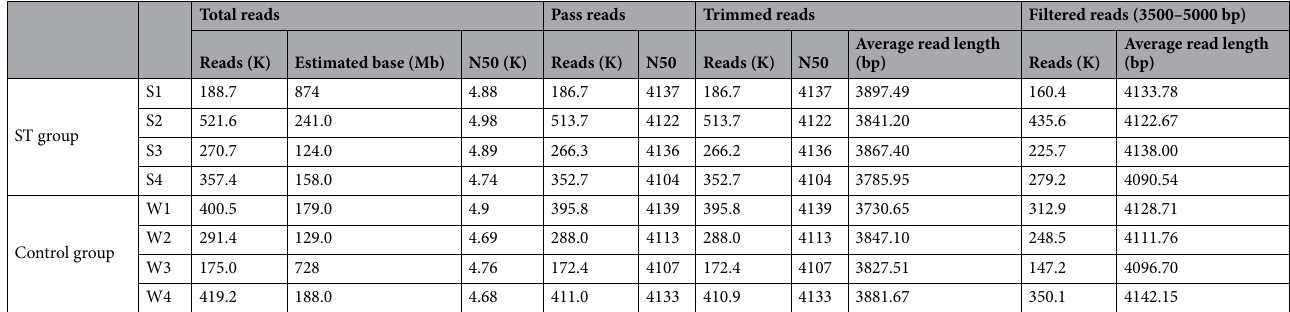
Table 2. Summary statistics for 16S–23S operon sequencing of the gut microbiome of the ST and control group.